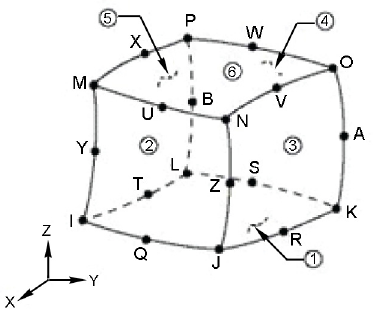
Fig. 6. A 3-D 20-node finite element SOLID186 (Moaveni